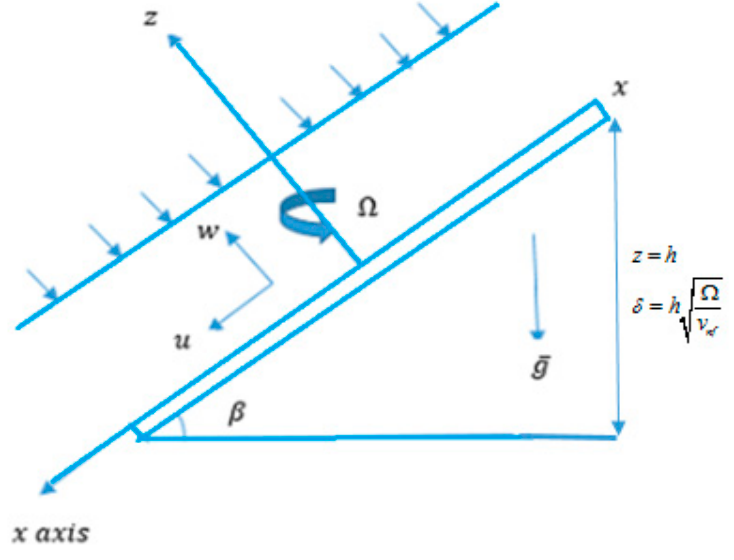
Figure 1. Geometrical sketch of the model.